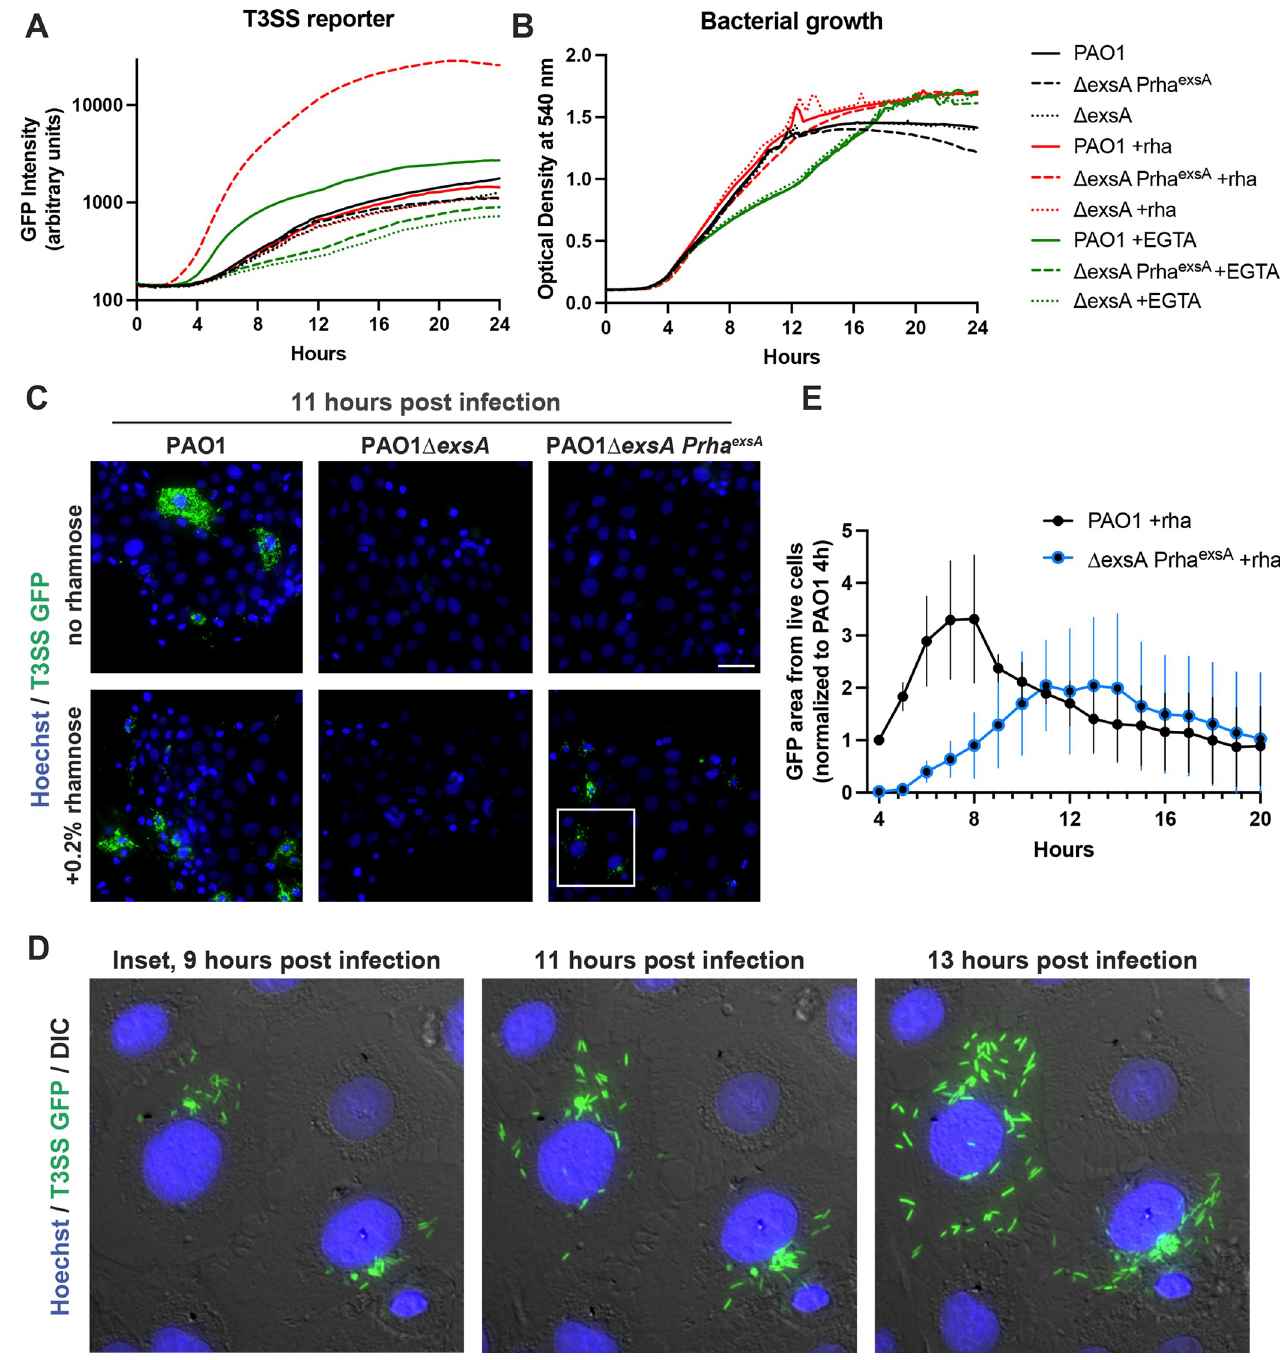
Fig 9. Intracellular induction of T3SS effector expression is sufficient to generate an intracellular niche. (A) A rhamnose-inducible ExsA construct was integrated at the Tn7 chromosomal site of PAO1 Δ exsA . Strains were transformed with the T3SS-GFP reporter pJNE05. Strains were grown in TSB, TSB with 2 mM EGTA, or 0.2% rhamnose. GFP intensity measured at 15 min intervals showed effective T3SS induction. (B) Absorbance at 540 nm was measured simultaneously with the experiment in (A) to indicate bacterial growth. (C) Indicated strains were visualized in a time-lapse format and 11 h post-infection shown with Hoechst and GFP. (D) Insets of the same field of induced ExsA expression at 9 h, 11 h and 13 h post-infection show the accumulation of spreading intracellular bacteria. (E) The GFP area accumulation in only live cells was summed and normalized to PAO1 at 4 h. Three replicates are shown with mean ±